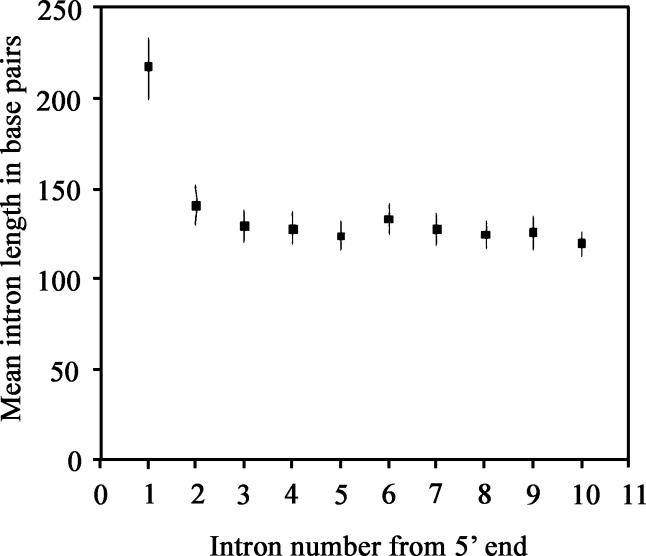
Mean Intron Length as a Function of Intron Position, Counting from the 5′ End of the GeneIntron length was nearly constant for introns 5 to 10. Proximity to the 3′ end of the gene was not correlated with intron length. Error bars show ± twice the standard error. The data shown are for genes with exactly ten introns so that positional effects from the 3′ ends can also be assessed.